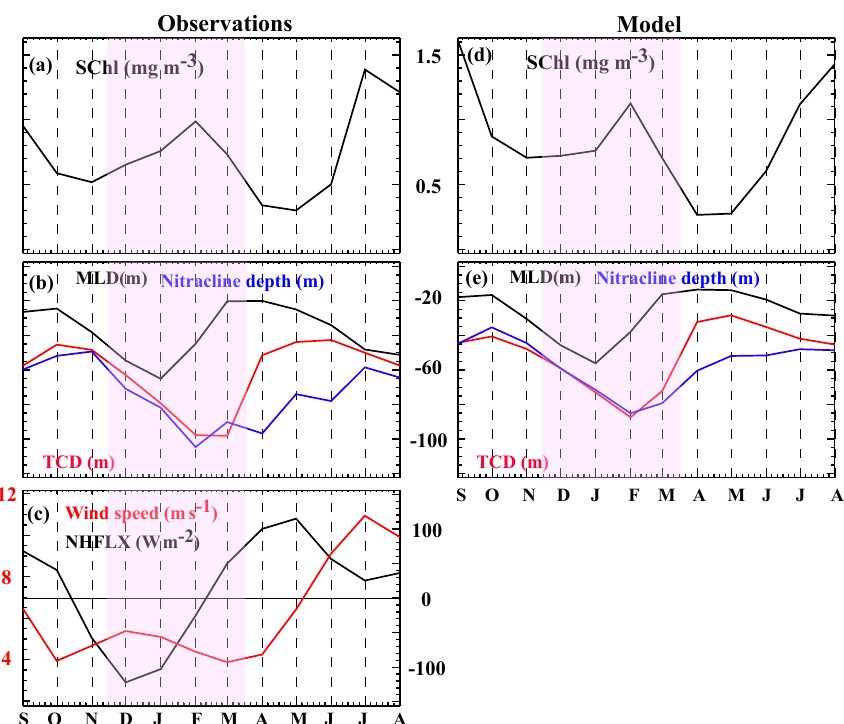
Figure 6. Mean seasonal cycle of NAS-box-averaged monthly (a) SChl; (b) MLD (black line), TCD (red line), and nitracline depth (blue line); and (c) surface net heat flux (NHFLX – black line) and wind speed (red line) in observations. (d–f) Same for model. The NAS box is outlined in Fig. 1. Note that the model average is based on the entire NAS box, while observations subsample this box: the good agreement between the two averages however suggests that observational subsampling does not introduce large biases.